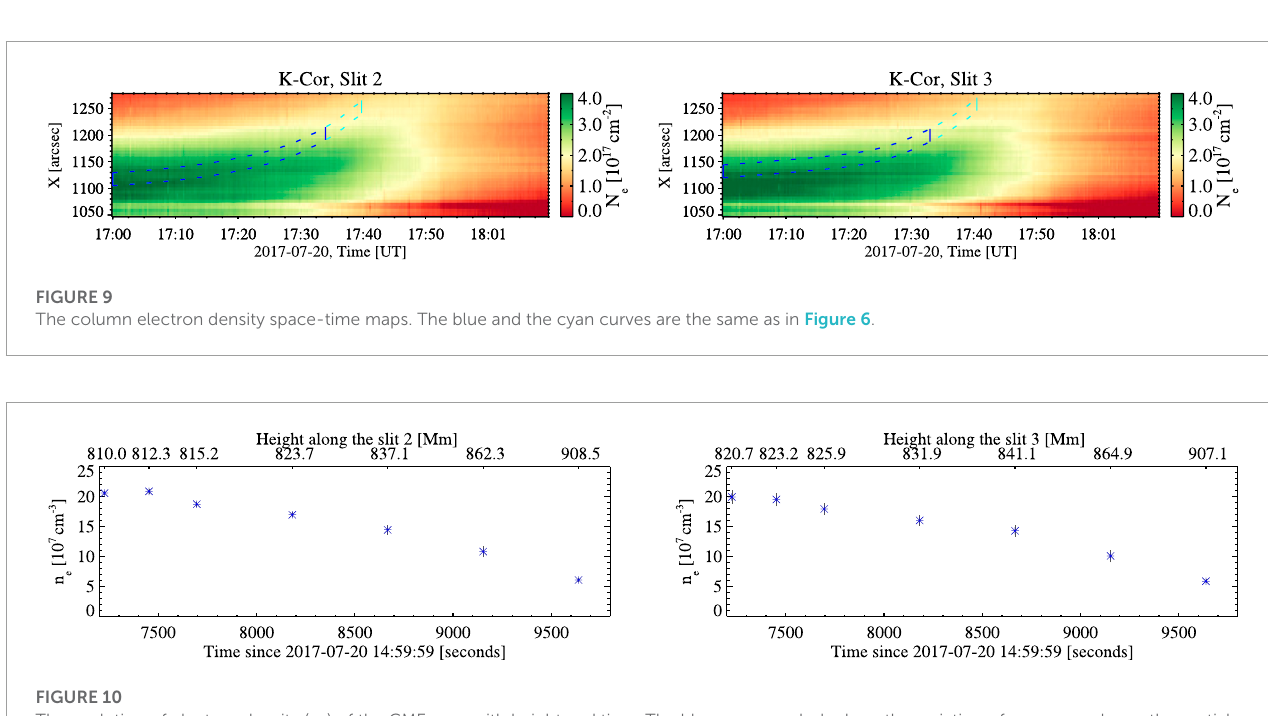
(due to the CME) can e ) obs ) assumed to e